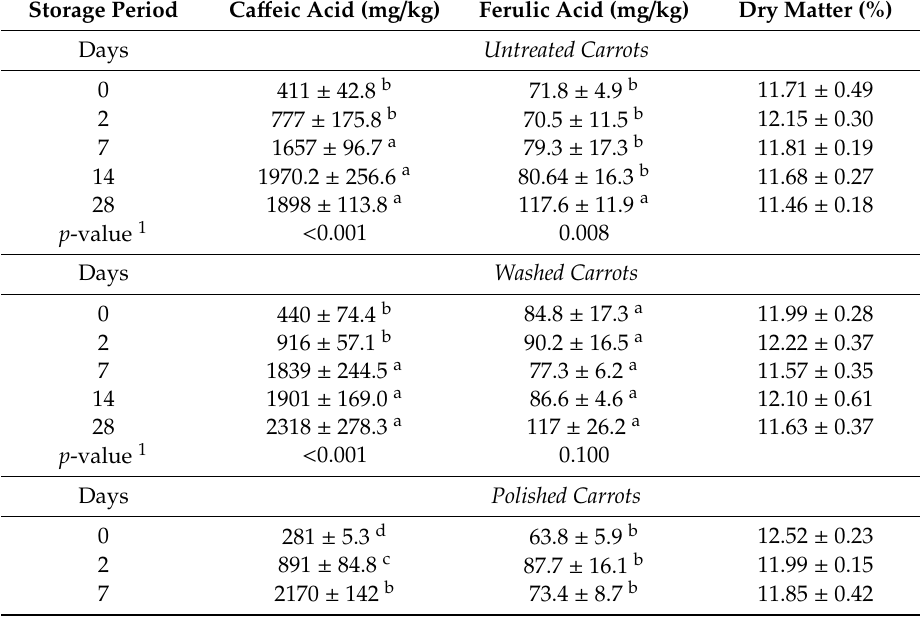
Table 3. Total ca ff eic and ferulic acid in carrot subjected to di ff erent technological procedures calculated as free